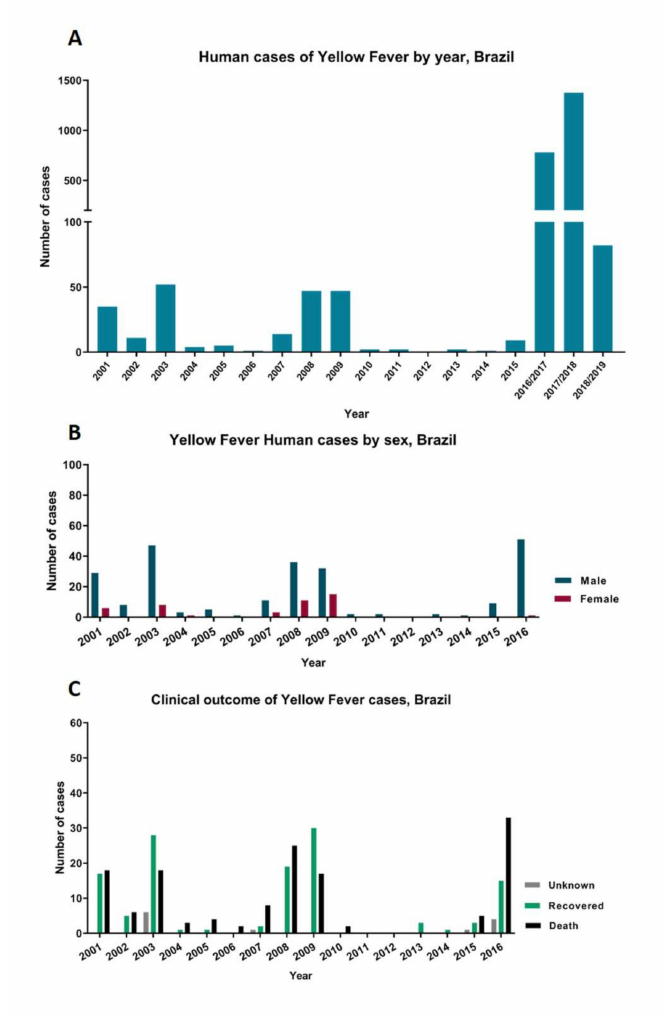
Figure 3. Distribution of human cases of YF in Brazil. ( A ) Distribution of confirmed human cases per year in Brazil for the monitoring period of (July to June) 2001–2019. ( B ) Distribution of YF human cases according to gender in Brazil during 2001–2016. ( C ) Clinical outcome of human cases of YF in Brazil during 2001–2016. All data was obtained from Sistema de Informaç ã o de Agravos de Notificaç ã o (SINAN), and epidemiological reports of the Brazilian Ministry of